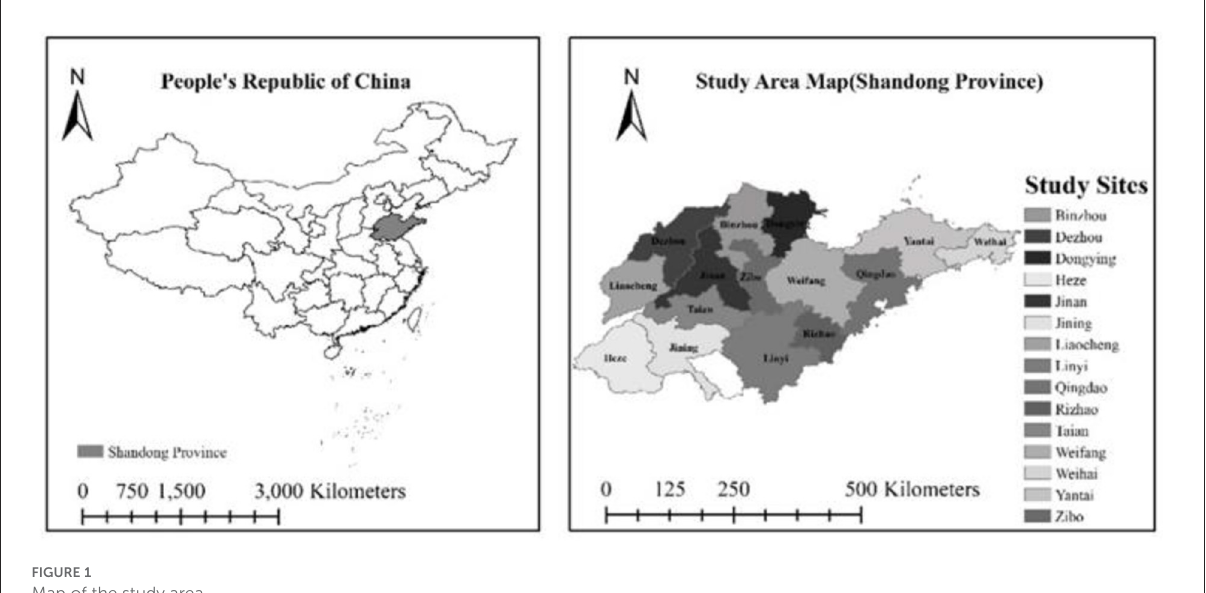
FIGURE1 Map of the study